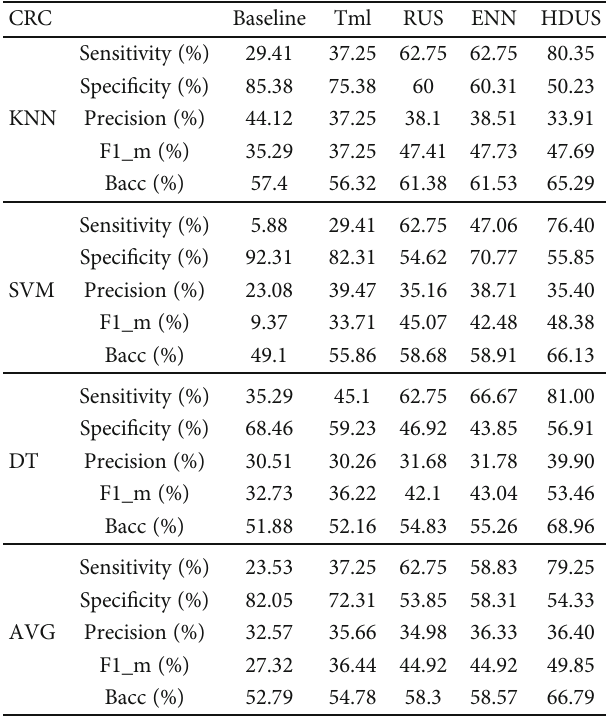
Table 5: Evaluation results for CRC dataset using classi fi ers (KNN, SVM, and DT) and models (baseline, Tml, RUS, ENN, and HDUS).